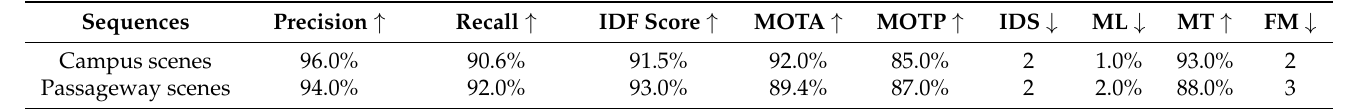
epochs. This is shown in Figures 6 and 8, with the ups and downs of the jumping of the